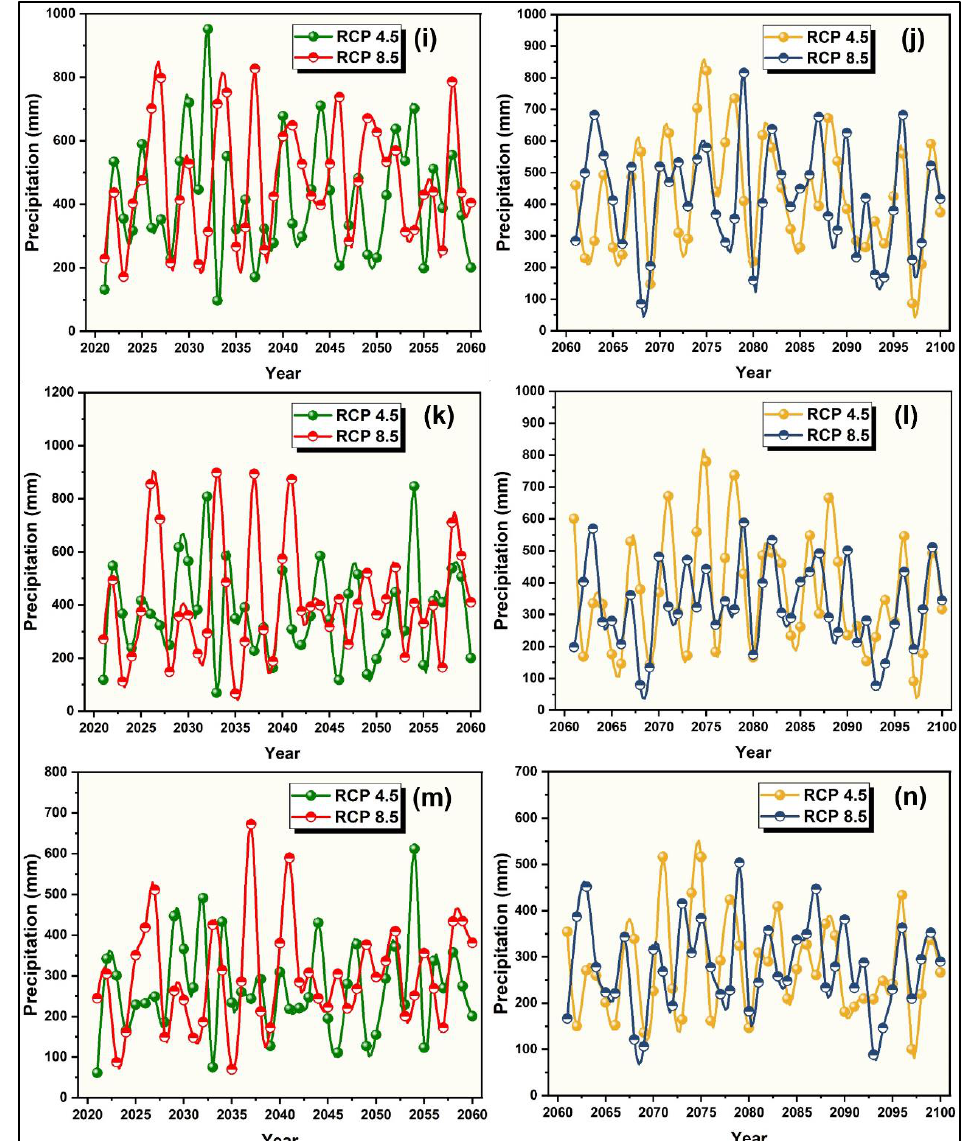
Figure 8. Future projection rainfall under RCPs 4.5 and 8.5 for midcentury (left) and latter century (right) in ( a , b ) Astore, ( c , d ) Diamir, ( e , f ) Ghanche, ( g , h ) Ghizer, ( i , j ) Skardu, ( k , l ) Gilgit, and ( m , n ) Hunza-Nagar.